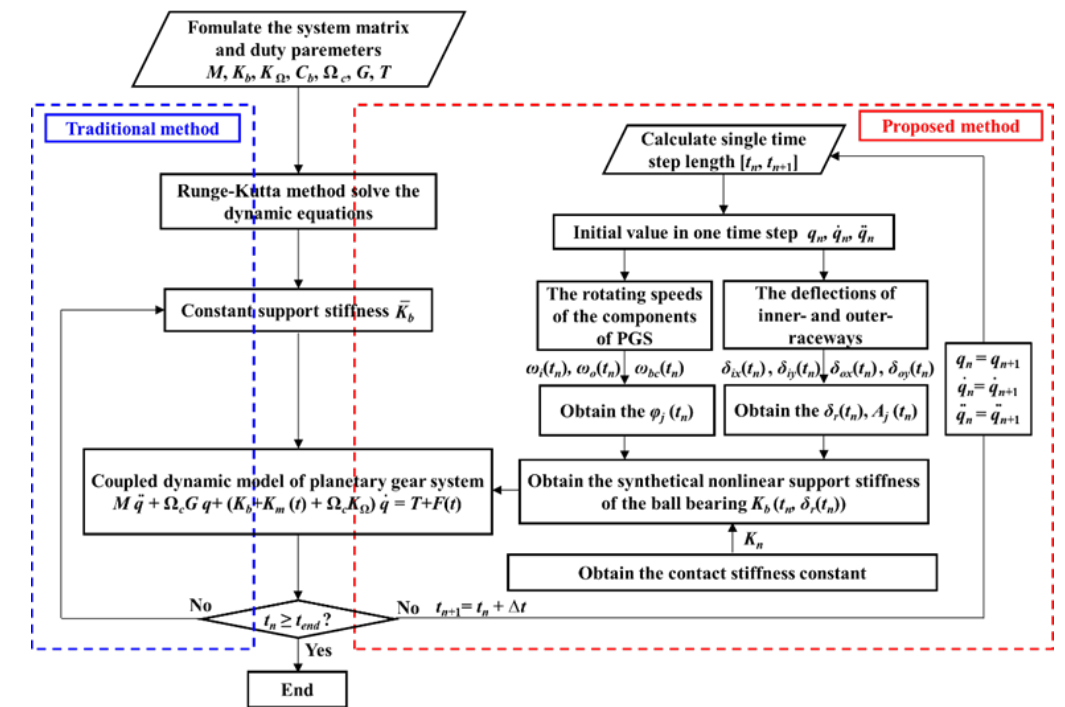
Figure 8. Flowchart of step-by-step time integration to obtain the dynamic response of the system.